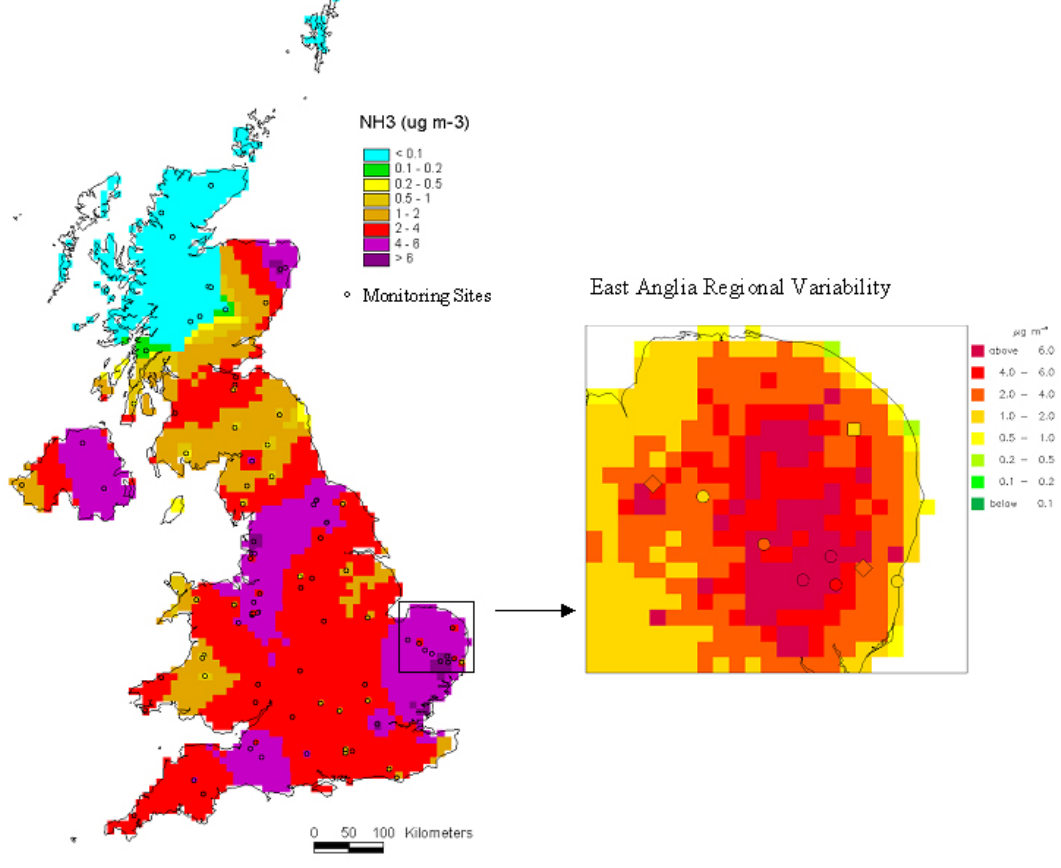
FIGURE 8 . Interpolated atmospheric NH 3 concentrations from the U.K. National NH 3 Monitoring network and map of East Anglia showing (as colored points) the NH 3 concentrations determined by the monitoring network on a background of the FRAME predicted